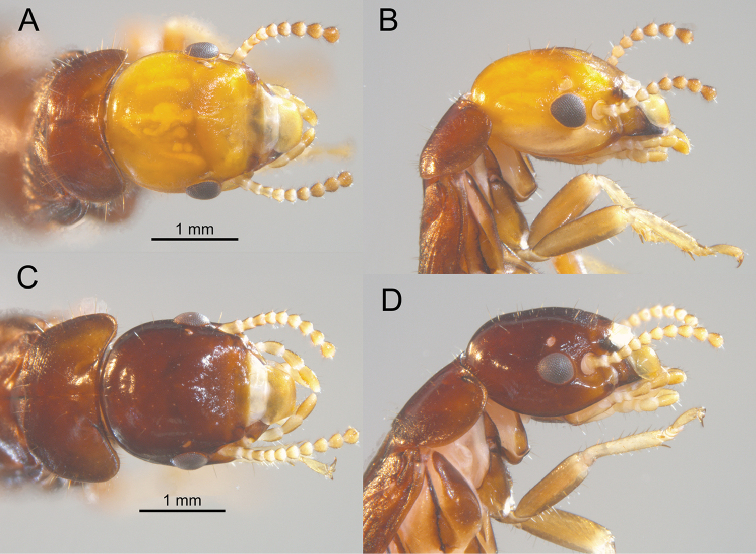
Head and thorax of the Rugitermes
rufus (A dorsal B lateral) and the R.
volcanensis (C dorsal D lateral) imagos.